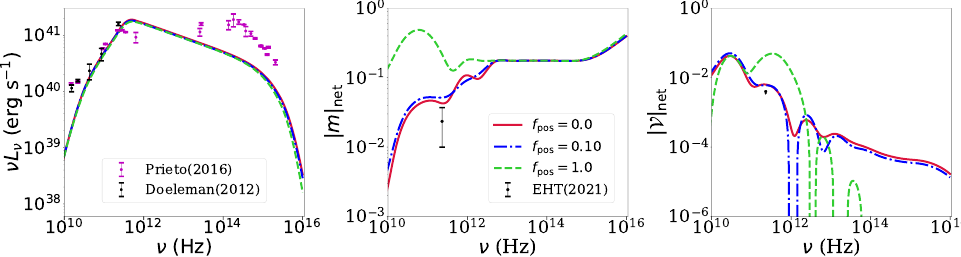
Figure 5. The spectrum of the best bet model for the jet model [9] with β e = 10 − 2 and p = 3.5. From the ( left ) to ( right ), we present the total intensity, the linear and the circular polarization, respectively. Overlaid on each panel, we also present the observational data points.